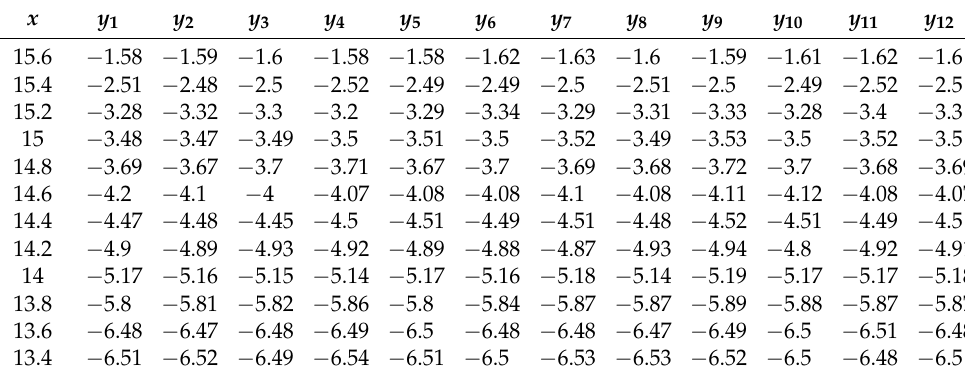
Table A3. The coordinates ( x , y ) of the ultrasound data points for the shape of the vitreous for 12 patients (part